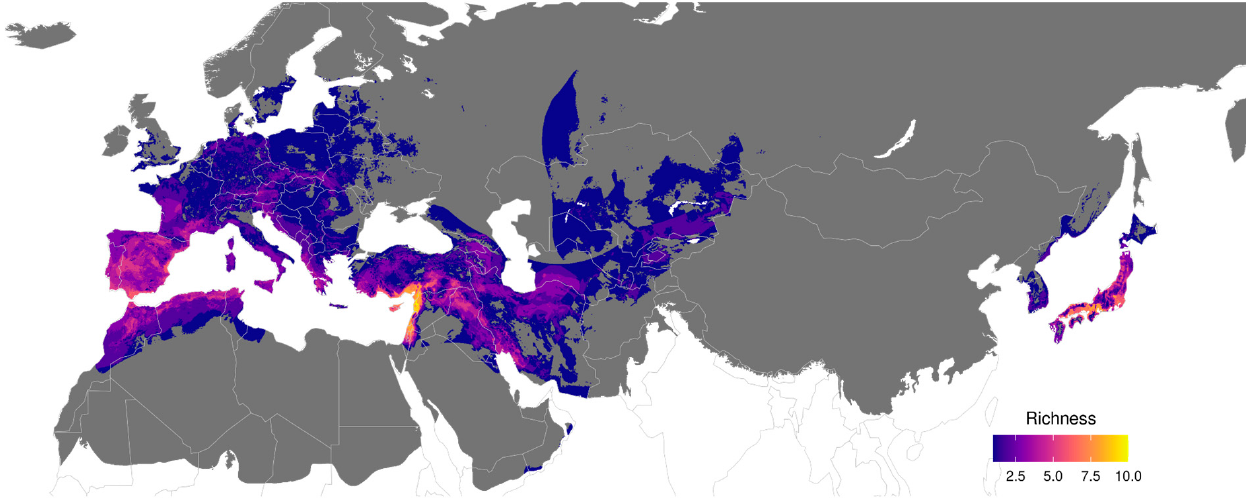
Figure 4. Distribution of the species richness for the IUCN Red List category Critically Endangered (2), Endangered (19), Vulnerable (12), or Near Threatened (16).